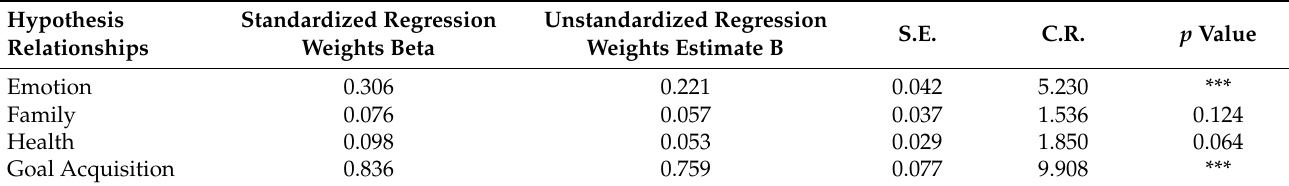
Table 2. Regression weights in the direct hypothesis